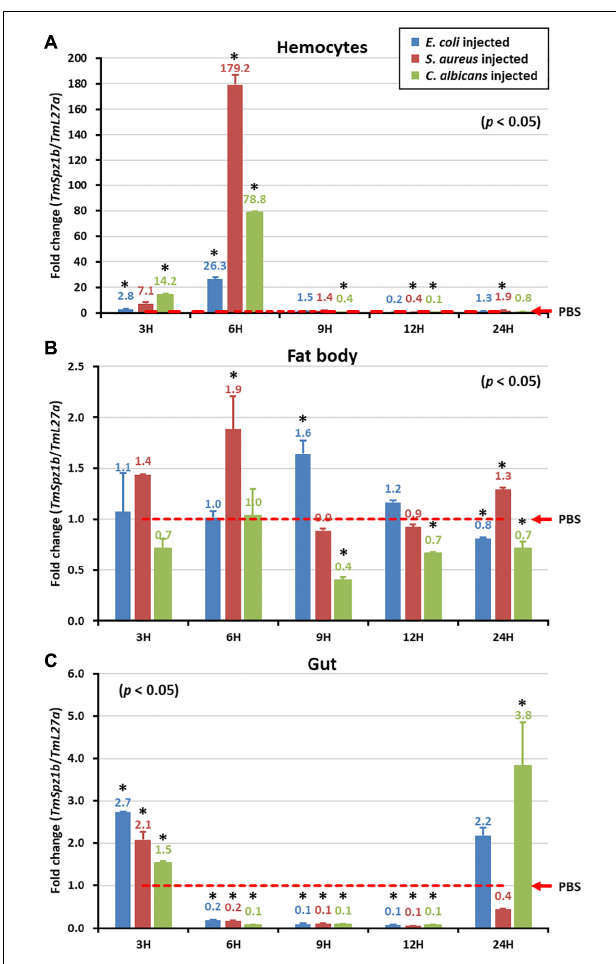
FIGURE 4 | Temporal expression patterns of TmSpz1b in three immune organs following microbial challenge. After injection of E. coli , S. aureus , or C. albicans , three immune organs including hemocytes (A) , fat bodies (B) , and the gut (C) were dissected and collected at 3, 6, 9, 12, and 24 h. TmSpz1b expression was analyzed by qRT-PCR. PBS-treated group was used as the mock control. The expression level of TmSpz-like mRNA in the mock control group was normalized to 1. Vertical bars depict the mean ± S.E. of three biological replicates. Significant differences ( P < 0.05) between the experimental and control group are indicated by asterisks ( ∗